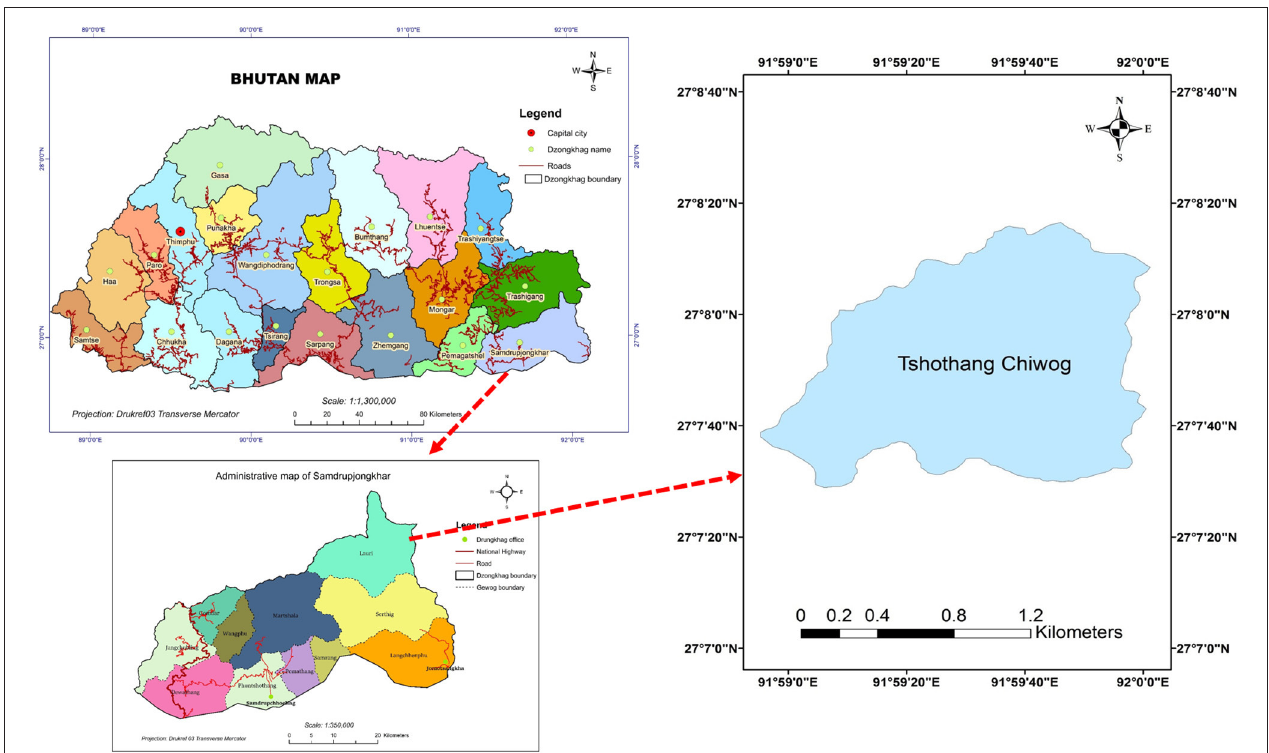
FIGURE 1 | Map of Bhutan showing the location of the study site (Tshothang Chiwog in Lauri Gewog, Samdrup Jongkhar). Bhutan and Samdrup Jongkhar maps reproduced with permission of the National Land Commission, Thimphu.